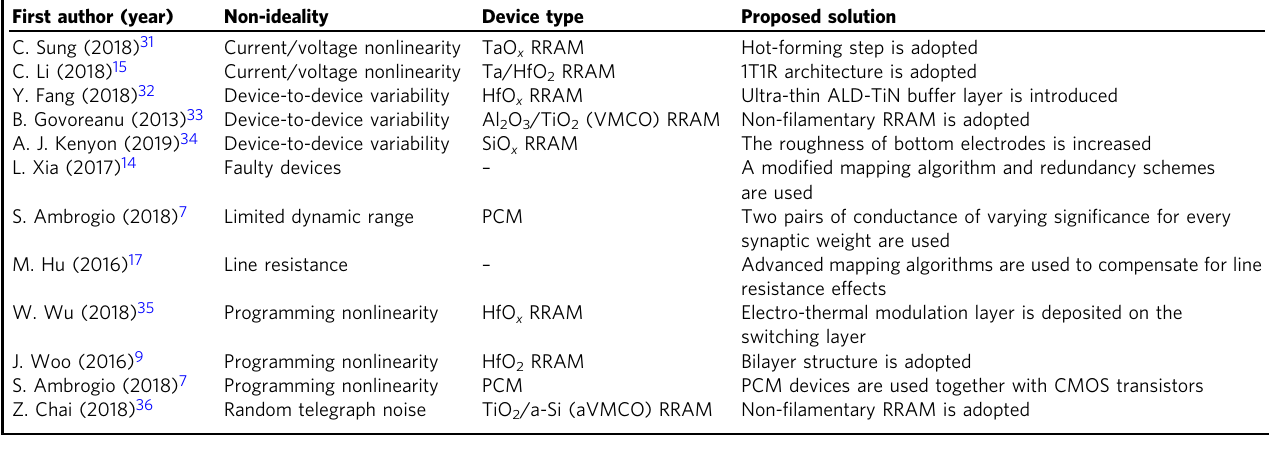
Table 1 Examples of past efforts at dealing with non-idealities of memristive devices and their systems.